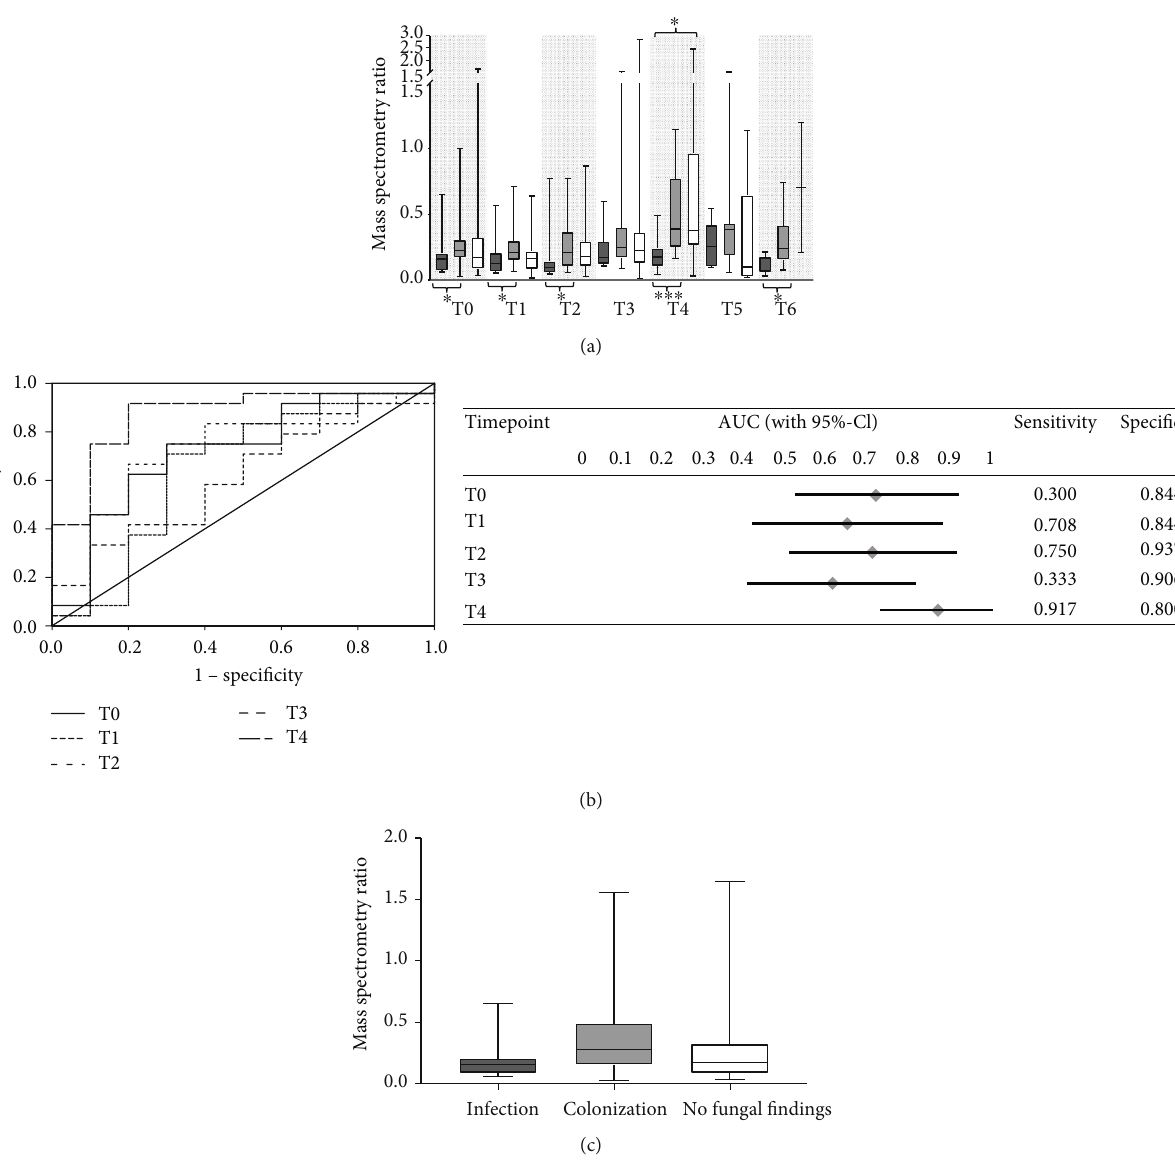
Figure 3: Plasma concentrations of thromospondin-1 for the detection of an IFI in patients with septic shock. (a) Plasma concentrations of thrombospondin-1 were measured by mass spectrometry in patients su ff ering from septic shock with an invasive fungal infection (IFI, dark grey box), a fungal colonization (light grey box), or without any fungal fi ndings (white box). Plasma samples were collected at the onset of septic shock (T0) and 1 day (T1), 2 days (T2), 7 days (T3), 14 days (T4), 21 days (T5), and 28 days (T6) afterwards. Data in box plots